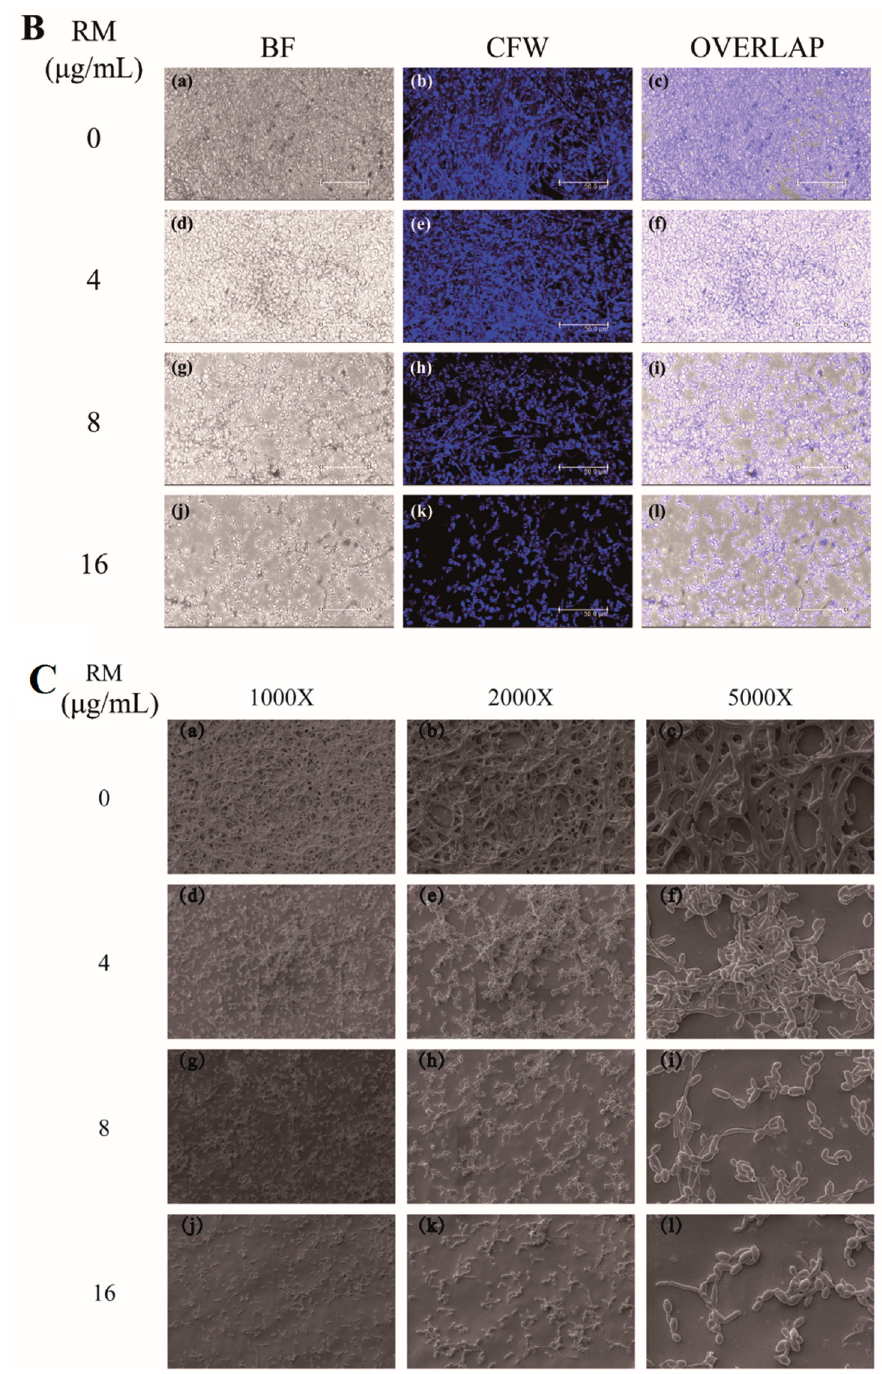
Figure 3. RM inhibits C. albicans SC5314 biofilm formation in vitro . ( A ) Inhibitory activity of different concentrations of RM on biofilm formation in four mediums (Spider, Lee’s, RPMI1640 and YPD + 10% FBS). * p < 0.05; ** p < 0.01; *** p < 0.001, compared to the control biofilms; ( B ) Effects of different concentrations of PTE on biofilm formation in Lee’s medium, shown in CLSM images. CFW, calcofluor white. Bar = 25 μ m; ( C ) Effects of different concentrations of PTE on biofilm formation in Spider medium, shown in SEM images. The inset in the 1000×, 2000× and 5000× panels show the area that was magnificated. ( a – c ): normal biofilm; ( d – f ): cells were treated with 4 μ g/mL RM; ( g – i ): 8 μ g/mL RM; ( j – l ): 16 μ g/mL